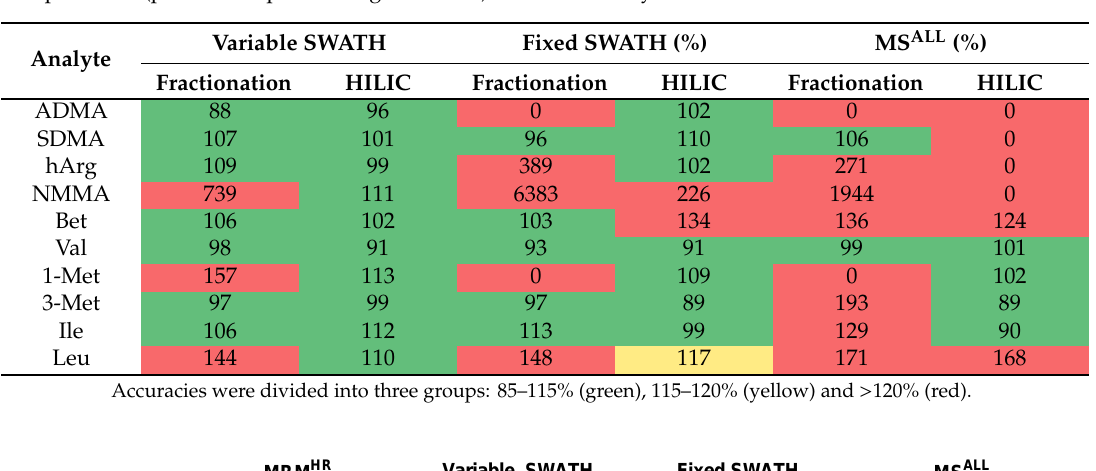
Table 2. The quantification accuracy of structural isomers in comparison with MRM HR . Compounds that could not be quantified due to an insufficient linearity (<0.99), high variability (>15%) or integrations problems (peak overlap or too high baseline) are indicated by the zero values.